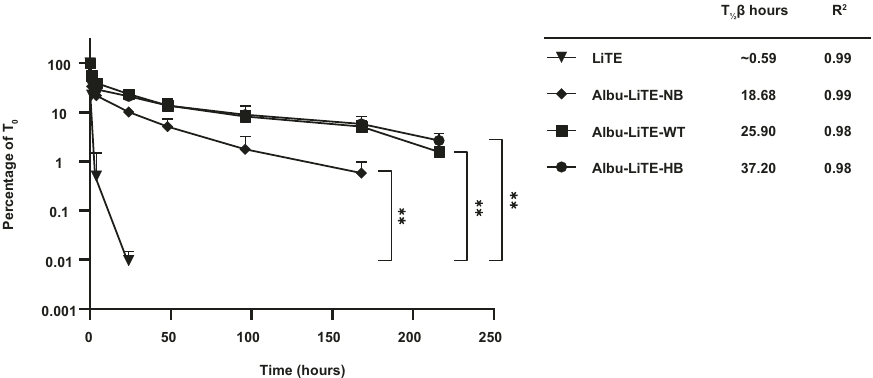
Fig. 3 Pharmacokinetic analysis of LiTE and Albu-LiTE constructs in the AlbuMus model. Protein was i.v. injected in 4 groups of mice ( N = 7 per group) and blood samples were drawn at 8 time points. Full size construct was detected in serum by ELISA. The β half-life and the R 2 of the fi t to the curve for each construct are listed for LiTE (triangle), Albu-LiTE-NB (diamond), Albu-LiTE-WT (square) and Albu-LiTE-HB (circle). Data was analysed with Graphpad prism v.8 using two-phase decay for calculating the molecular half-life ( T ½ β ) and statistical differences between the constructs, detected in serum over time using a two-way ANOVA with multiple comparisons and Tukey ’ s post hoc correction. ** p < 0.01. Error bars represent standard deviations.